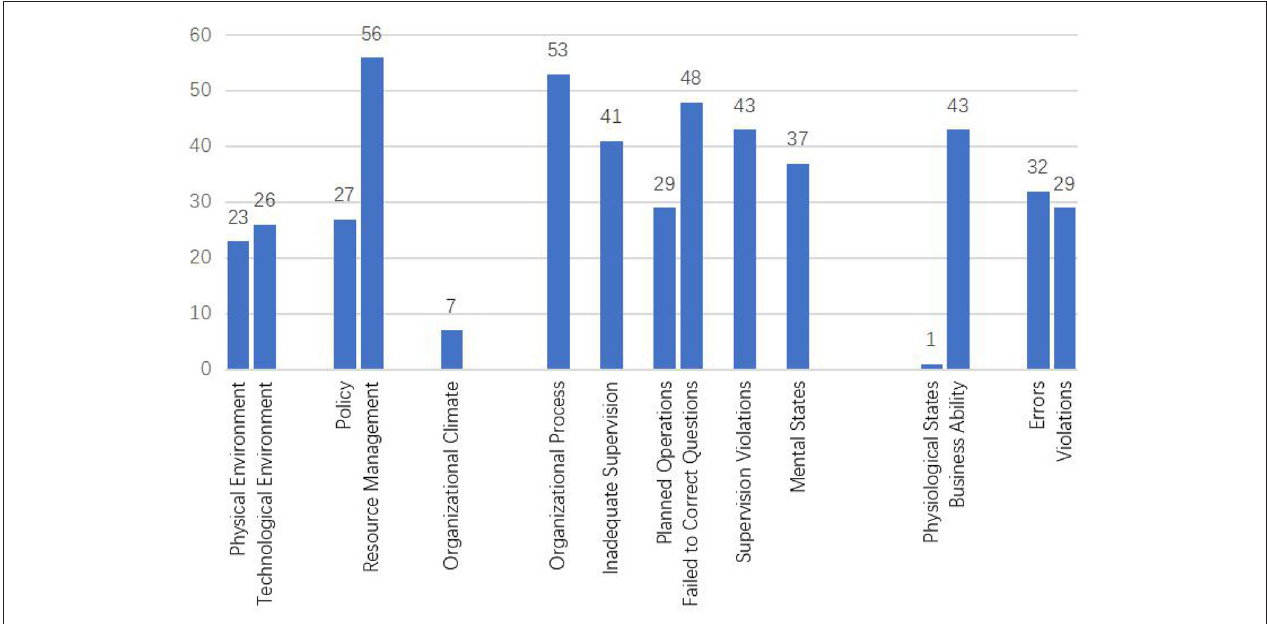
FIGURE 6 | Statistics of influencing factors of unsafe